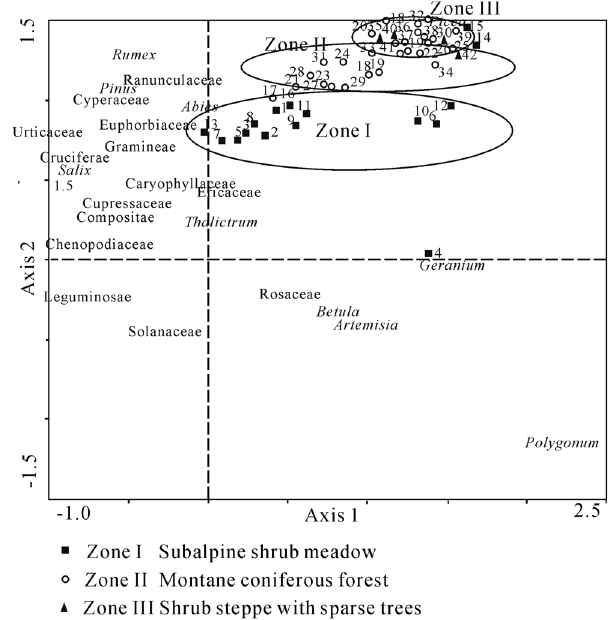
Figure 3. Ordination results of 42 surface pollen samples and 24 pollen taxa based on detrended correspondence